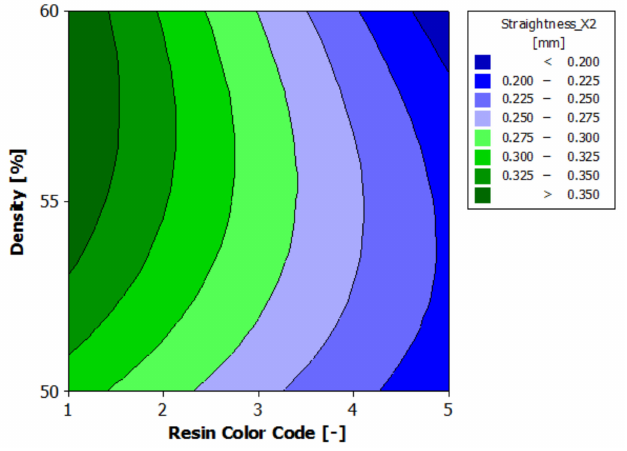
Figure 19. Contours of estimated response surface for Straightness_X2. Contour Y1